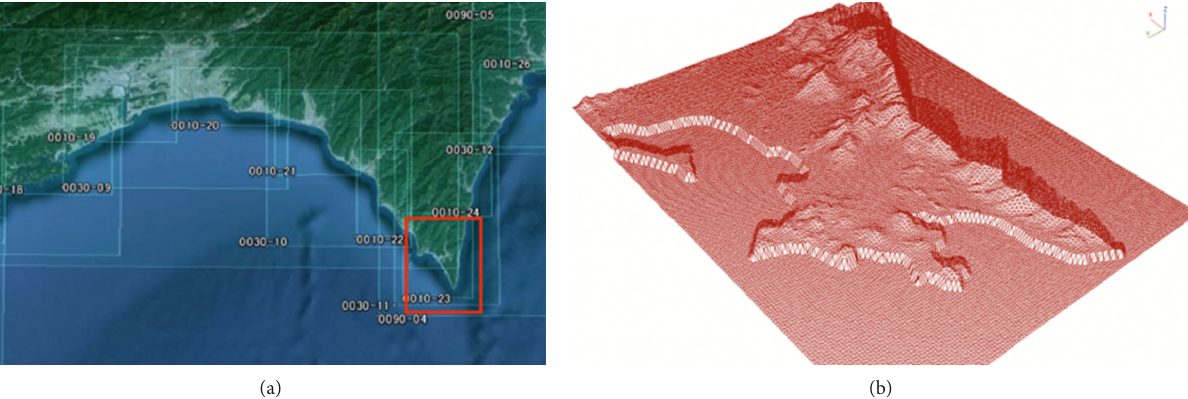
Figure 3: Basic rocket ship design. The rocket ship is propelled with three thrusters and features a single viewing window. The nose cone is detachable upon impact. (a) Specification of a region from GIS repository. (b) Polygonized terrain data corresponding to red region in (a).